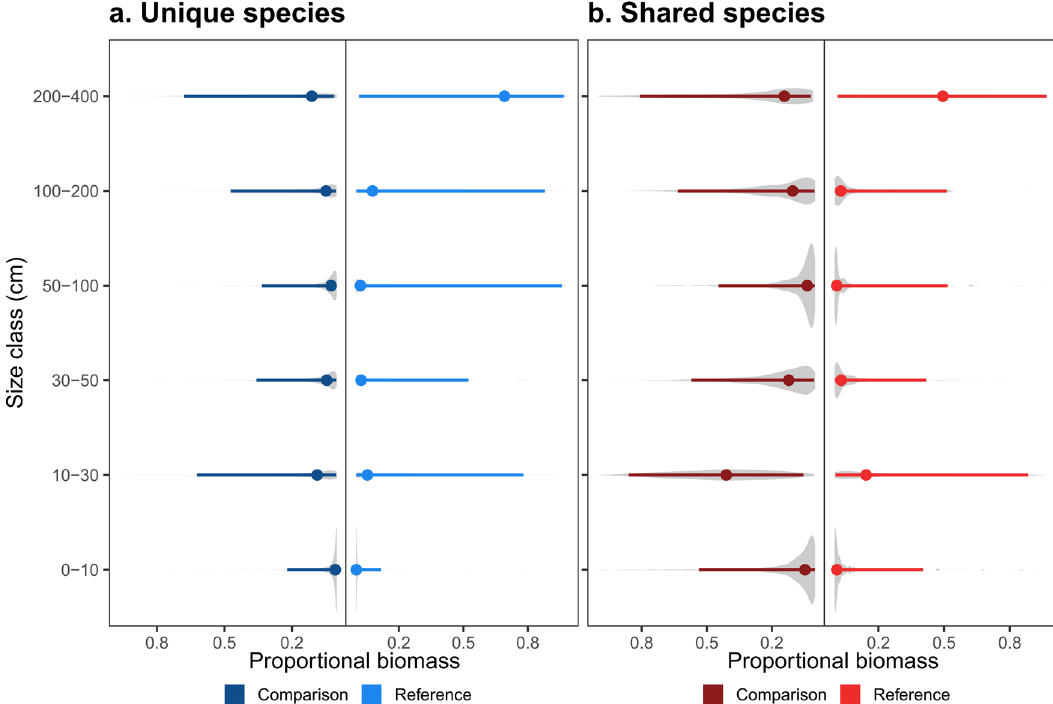
Fig. 5 Contributions of fi sh size to total fi sh biomass at comparison and reference sites. A A much larger proportion of the biomass of species unique to reference sites was attributable to large fi shes (>200 cm), as compared to species that were only found at comparison sites. B Among those species that were shared between both the reference and comparison sites, small fi sh (<50 cm) made up a much larger proportion of the total biomass, especially at the comparison site. Points are medians ±95% quantiles, and the gray shaded area shows the underlying distribution of raw data. The total number of individuals represented in the plot is n =